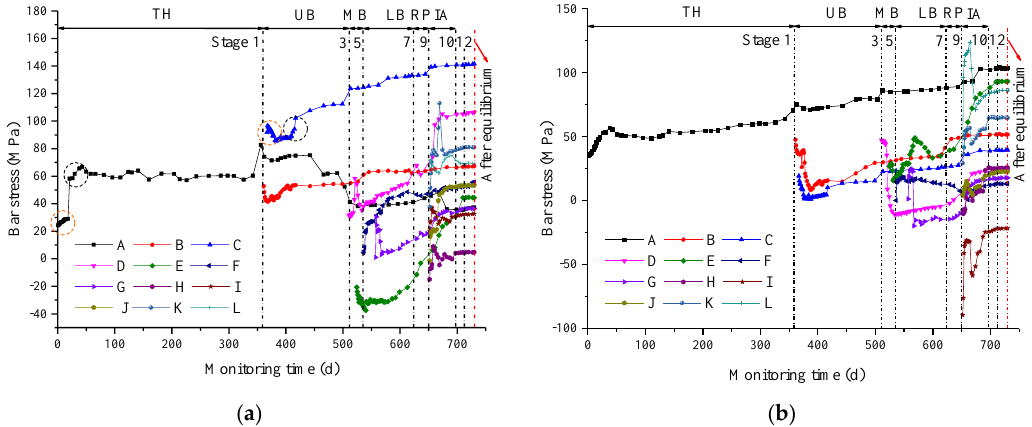
Figure 17. Time history plots of the internal forces in the four bar lattice girders: ( a ) inner side; ( b ) outer side.